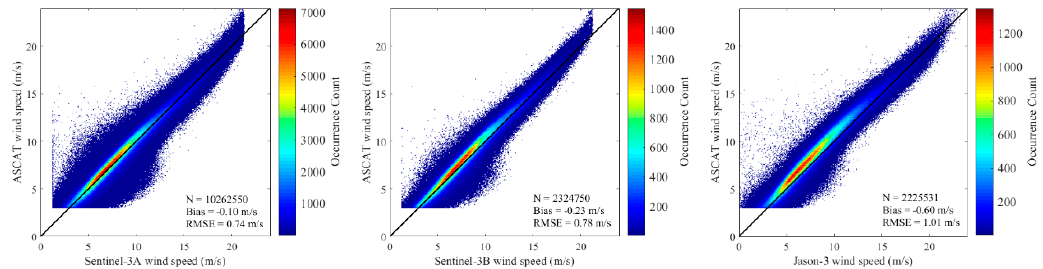
Figure 7. Comparisons of WS between the Sentinel-3A / 3B and Jason-3 altimeters and Advanced Scatterometer (ASCAT).